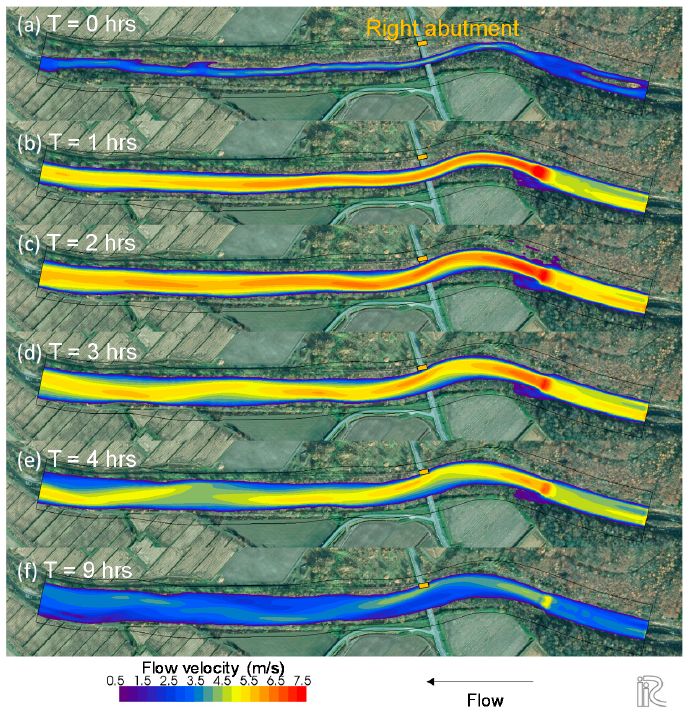
Figure 6. Temporal variation of flow velocity. The riverbank was eroded by the fast flow near the outer bank of the bend. The yellow square indicates the right abutment.